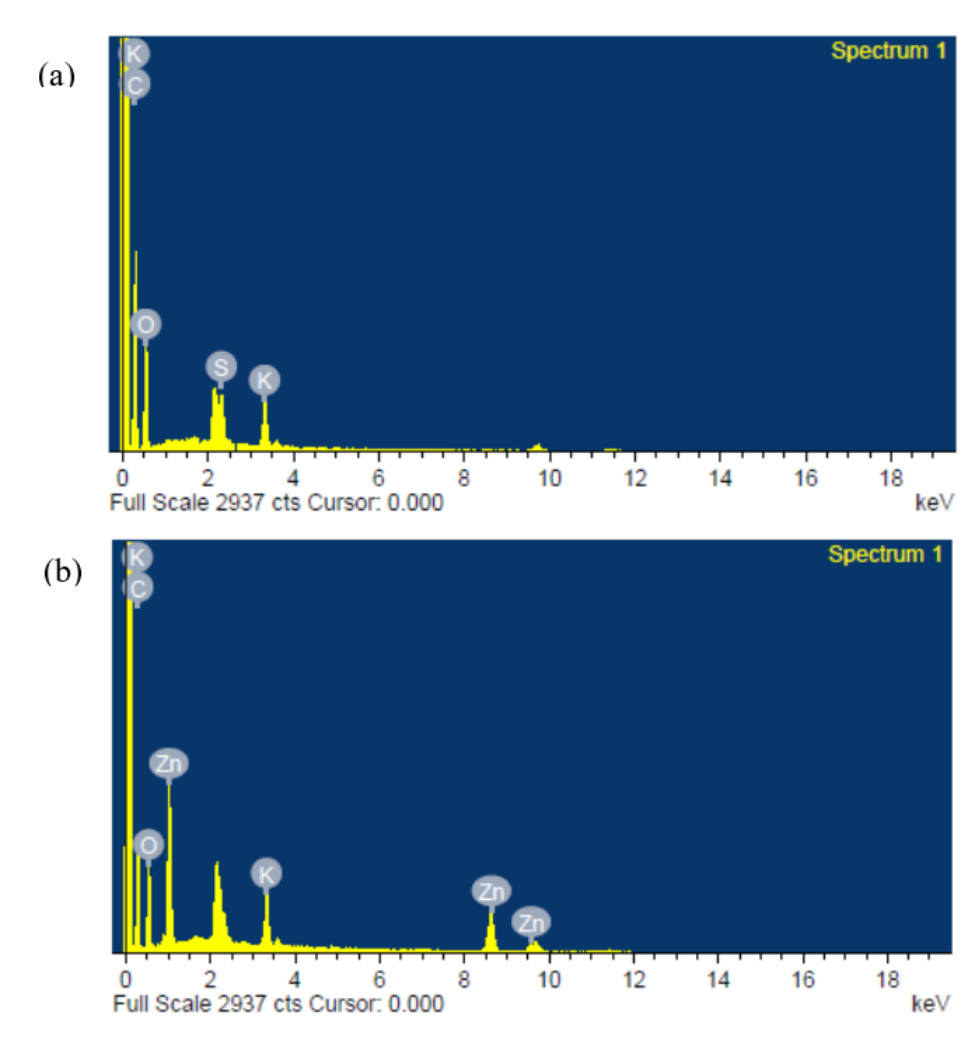
Figure 5. Typical energy-dispersive X-ray (EDX) plots of the composite polymer electrolytes of ( a ) PZ0 and ( b ) PZ10, showing successful incorporation of Zn into PVA–CA–K 2 CO 3 .